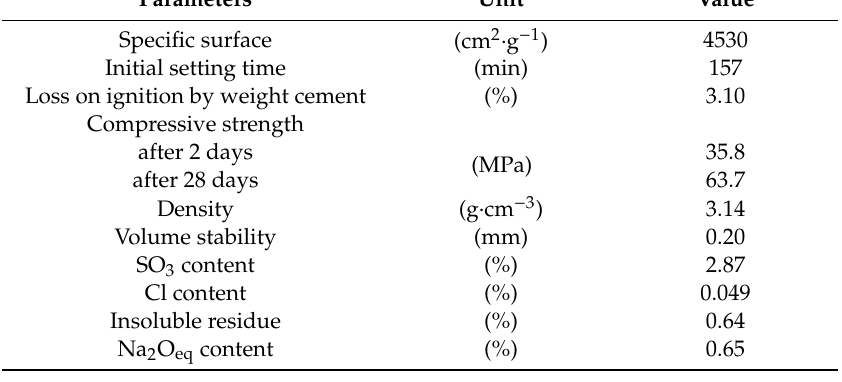
Table 1. Technical parameters of CEM I 52.5R Portland cement [34].